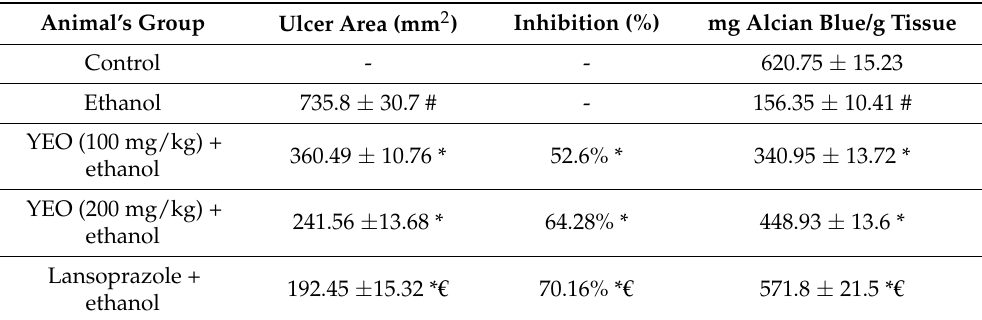
Table 1. The actions of the YEO on gastric ulcer area, inhibition % and Alcian blue binding ability in various experimental groups.